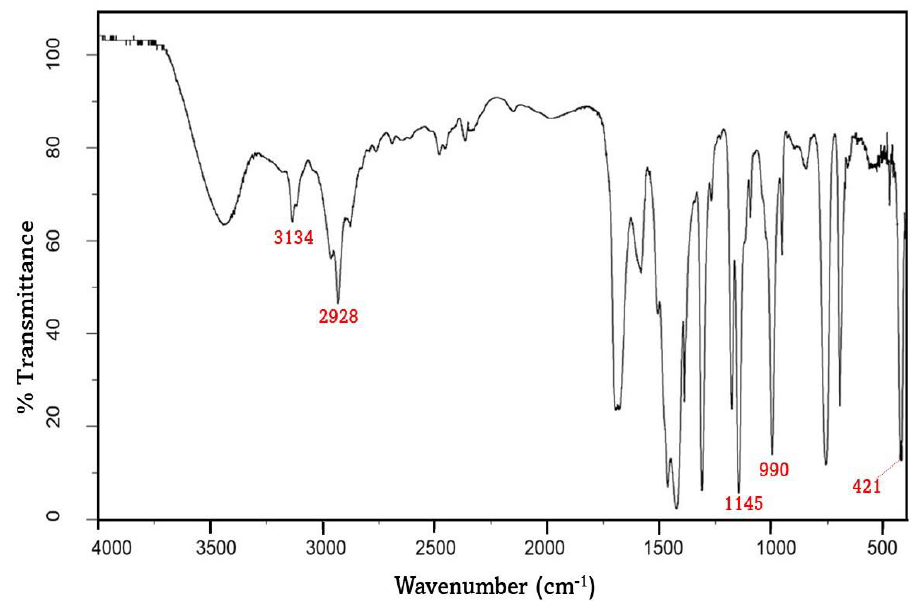
Figure 2. FTIR peaks of ZIF-8 nanoparticles.